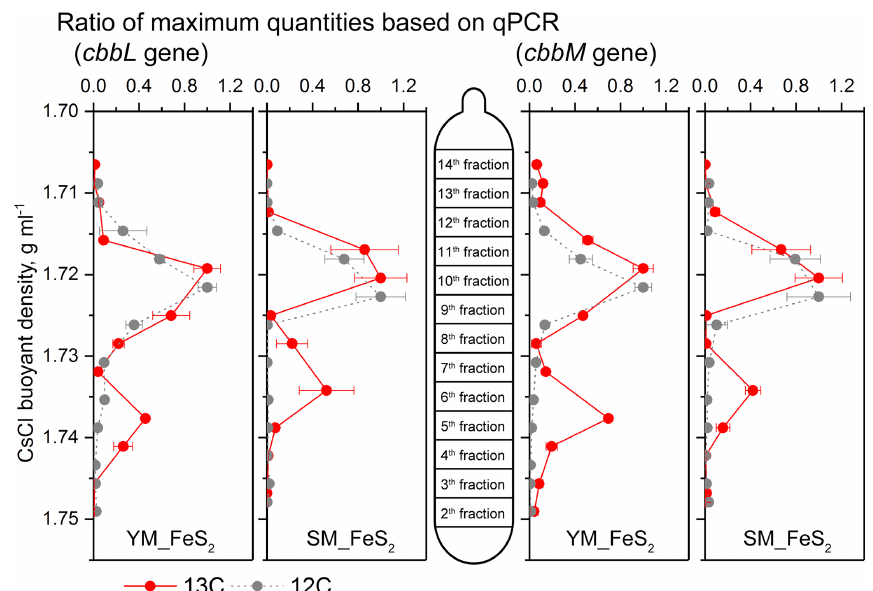
Figure 5. Quantitative distribution of cbbL and cbbM gene fragments across the entire buoyant density gradients of the DNA fractions from microcosms treated with FeS 2 and incubated with 12 C-CO 2 or 13 C-CO 2 . The normalized data consist of the ratio of the gene copy number for each DNA gradient to the maximum quantity for each treatment. The error bars represent the standard errors of triplicate microcosms, and each consisted of three technical replicates. cbbL and cbbM gene abundance qPCR data are presented in the